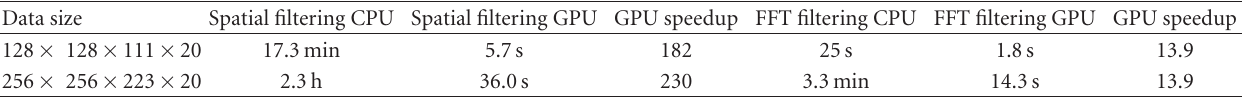
Table 3: Processing times for filtering with the 14 monomial filters of size 7 × 7 × 7 × 7 and calculating the 4D tensor for the di ff erent implementations. The processing times for the GPU do not include the time it takes to transfer the data to and from the GPU.